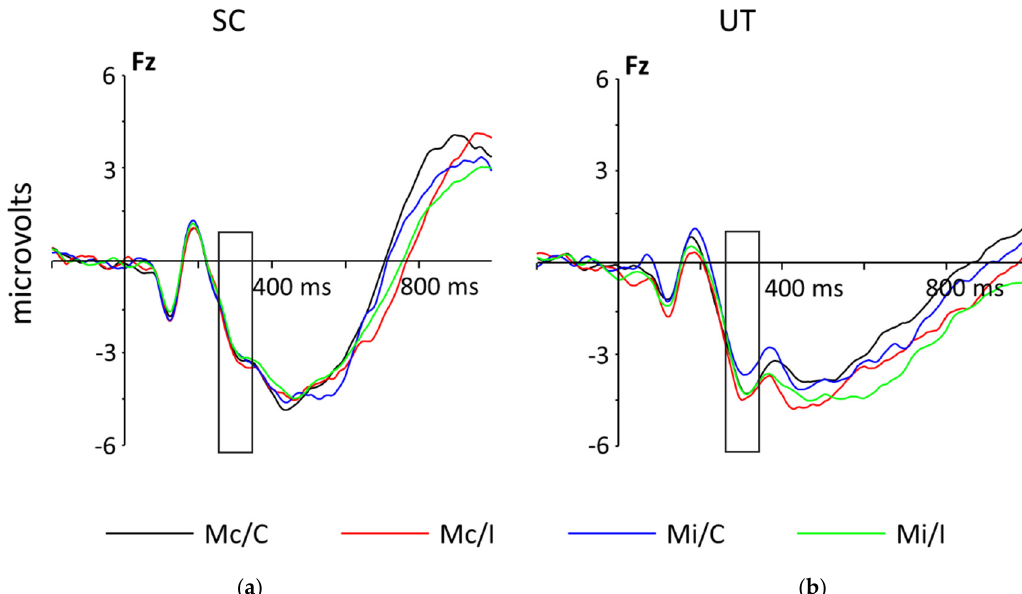
Figure 3. Grand-averaged stimulus-locked ERPs at electrodes Fz demonstrating the time course of the N2 for ( a ) participants who played SC and ( b ) participants who played UT. The UT group shows a slight pattern of I trials being more negative in both blocks, but overall, there were no significant differences between the gaming groups.